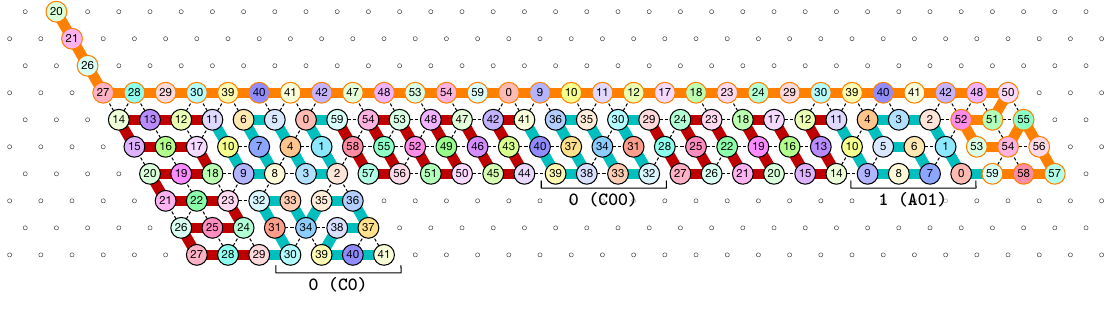
Figure 9. During the zag pass, all modules start from the bottom row, computing the value of each new bit by rewriting shapes A00 and A11 as C0 , C00 and C11 as A0 , A10 and A01 as C1 , and C10 and C10 as A1